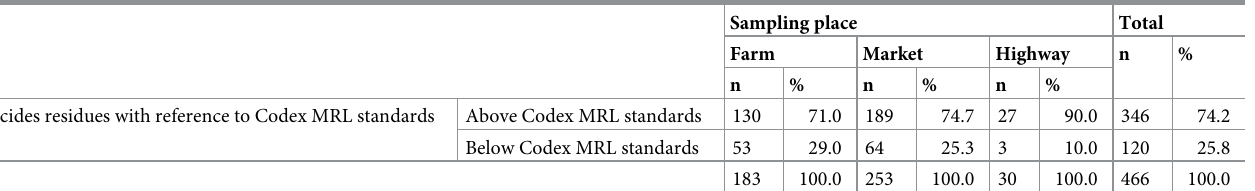
Table 6. Levels of pesticides residues by sampling